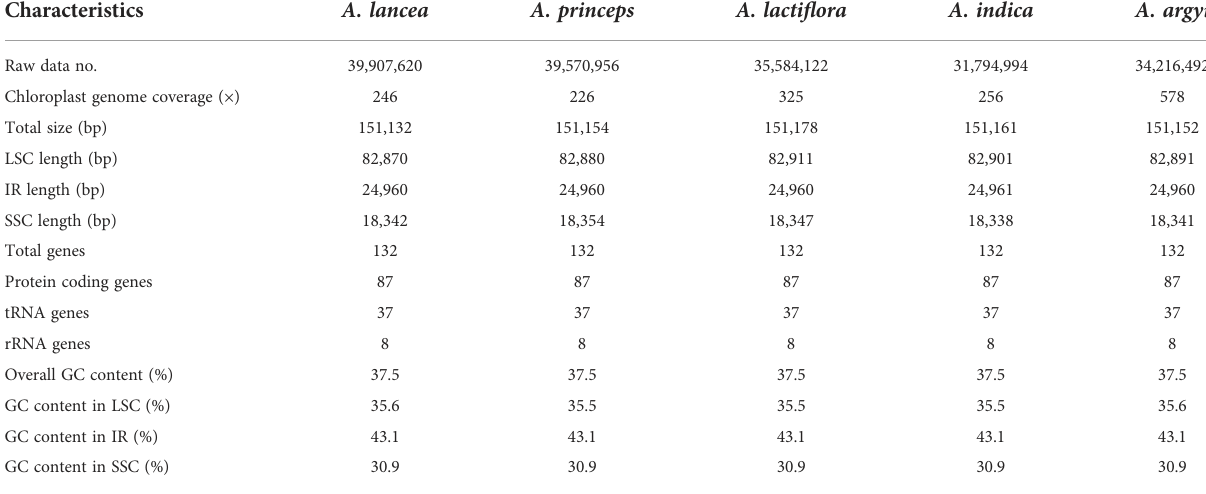
TABLE 1 Basic cp genome information of fi ve Artemisia species.